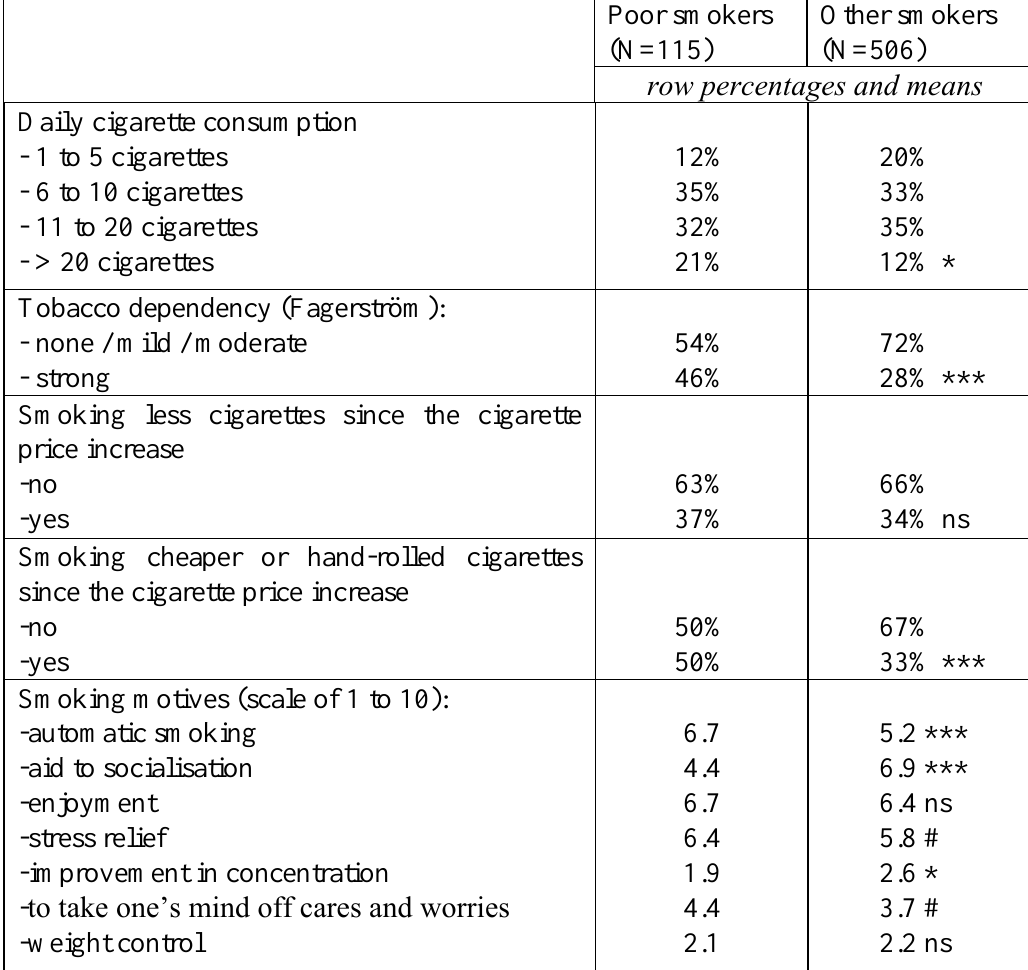
Table 2. Smoking behaviours and motives of poor smokers and other smokers, France,